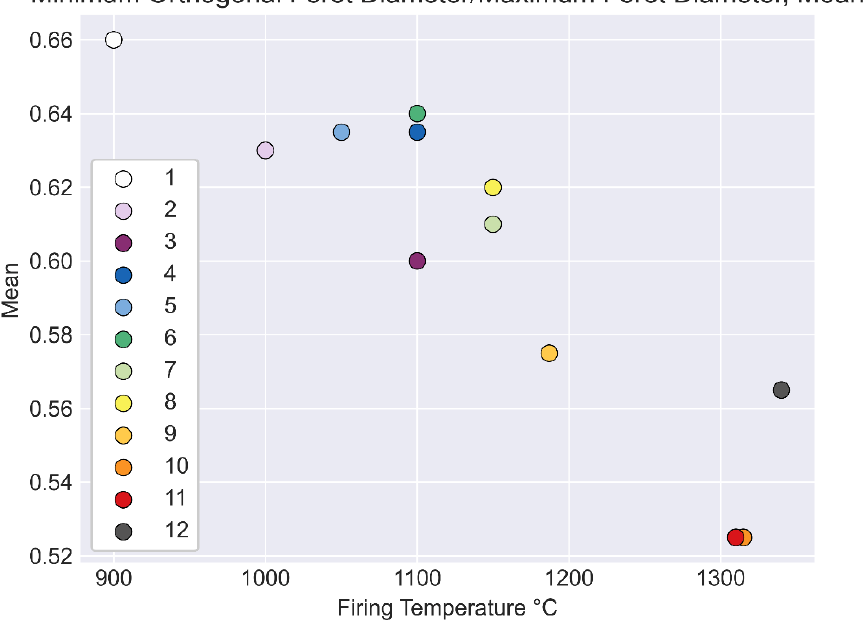
Figure 11. The minimum orthogonal Feret diameter/maximum Feret diameter, a measure of pore elongation, decreases with higher firing temperatures. Points are mean of 2.